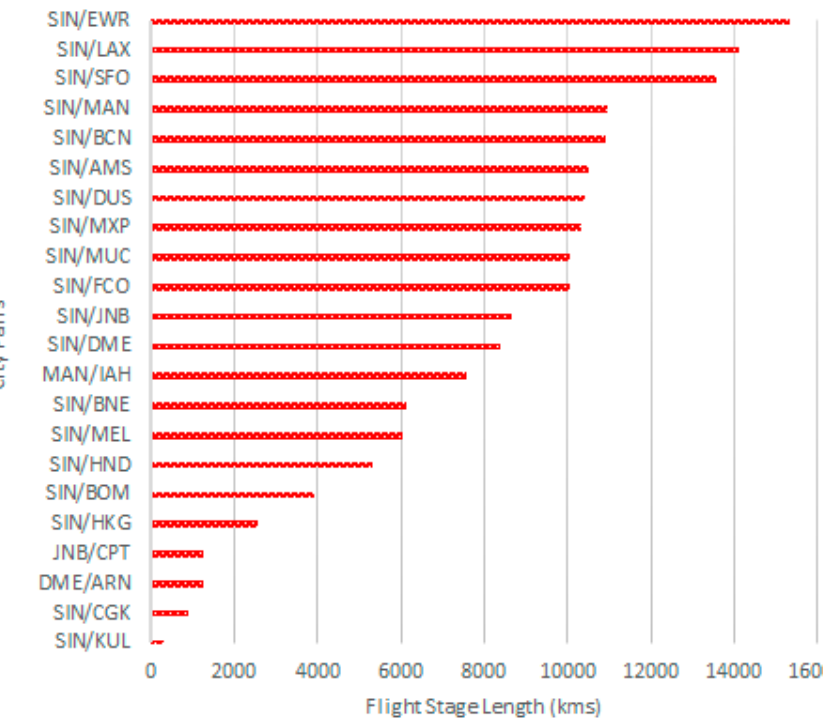
Figure 6. Singapore Airlines Airbus A350-900XWB flight stage lengths. Legend: AMS = Amsterdam, ARN = Stockholm Arlanda Airport, BNE = Brisbane, BCN = Barcelona Airport, BOM = Chhatrapati Shivaji International Airport (Mumbai), CGK = Jakarta, CPT-Cape Town, DME = Domodedovo Airport (Moscow), DUS = Düsseldorf, EWR = Newark Liberty International Airport, FCO = Leonardo da Vinci–Fiumicino Airport (Rome), HKG-Hong Kong, HND = Haneda Airport (Tokyo), IAH = George Bush Intercontinental Airport (Houston), JNB = Johannesburg Airport, KUL = Kuala Lumpur, LAX = Los Angeles International Airport, MAN = Manchester Airport, MEL = Melbourne, MXP = Milan–Malpensa Airport, MUC = Munich Airport, SFO = San Francisco, SIN = Singapore.